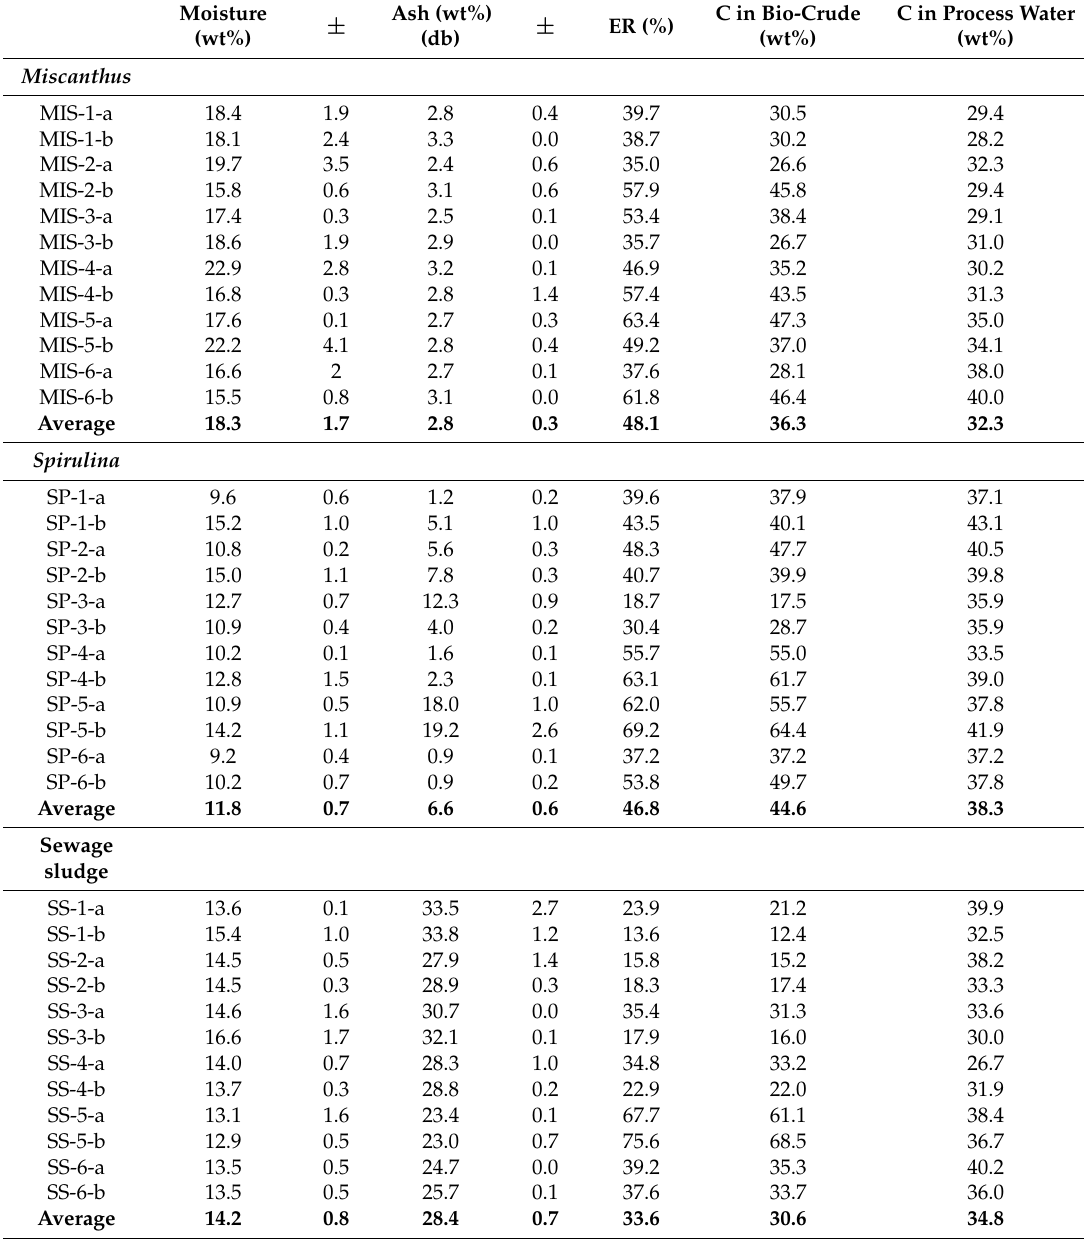
Table 5. Proximate analysis, energy recovery (ER) and carbon partitioning in bio-crudes from HTL of Miscanthus (MIS), Spirulina (SP) and sewage sludge